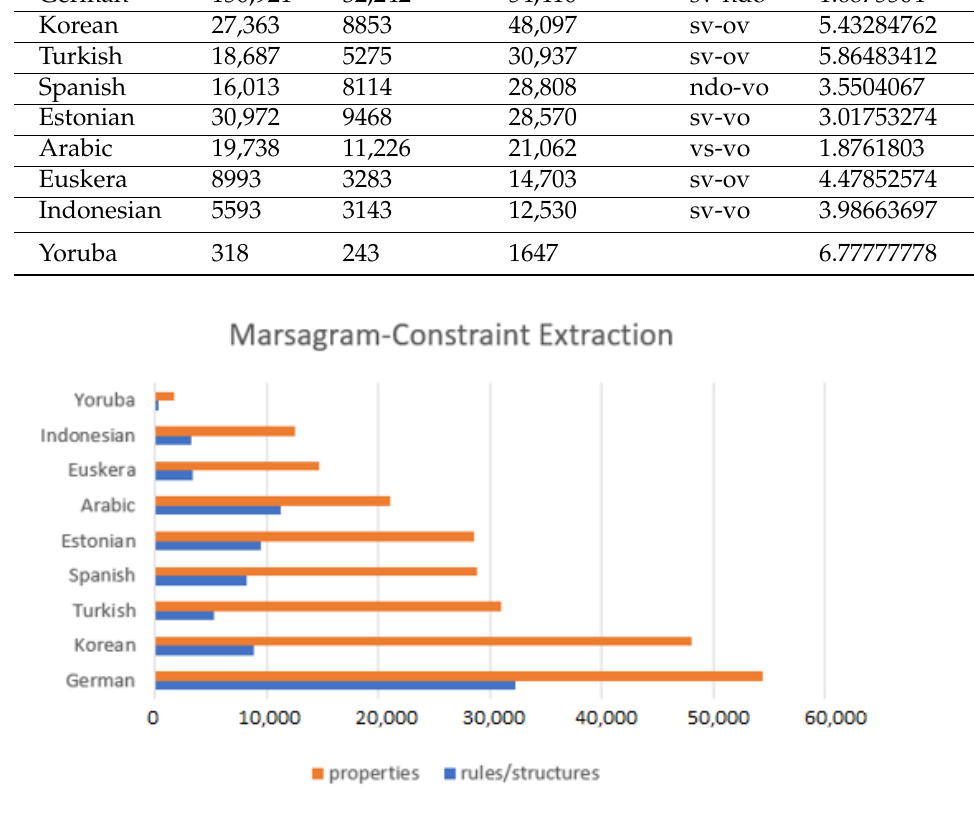
Figure 4. Quantitative data of